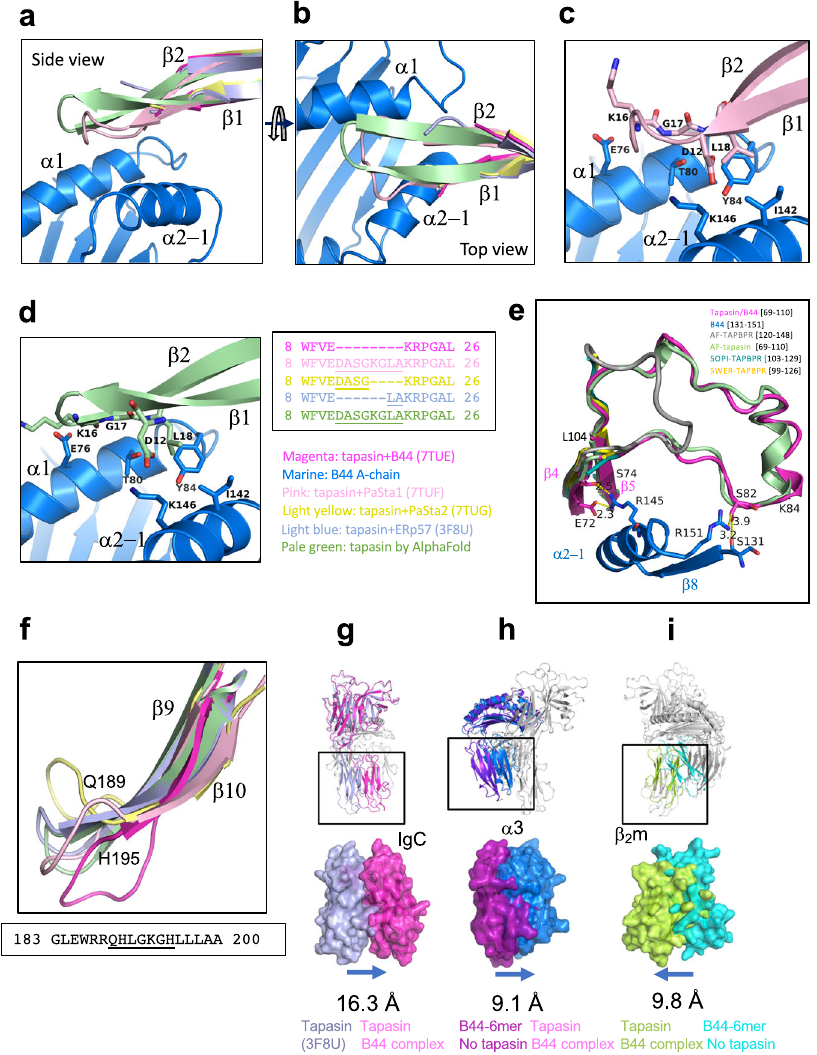
Fig. 6 | Loop movements and domain fl exibility of tapasin. Four X-ray deter- mined structures (3F8U, 7TUE,7TUF,7TUG) and the AlphaFoldmodel (AF-015533) were superposed. a – d illustrate the β 1 and β 2 strands of tapasin (Trp8 to